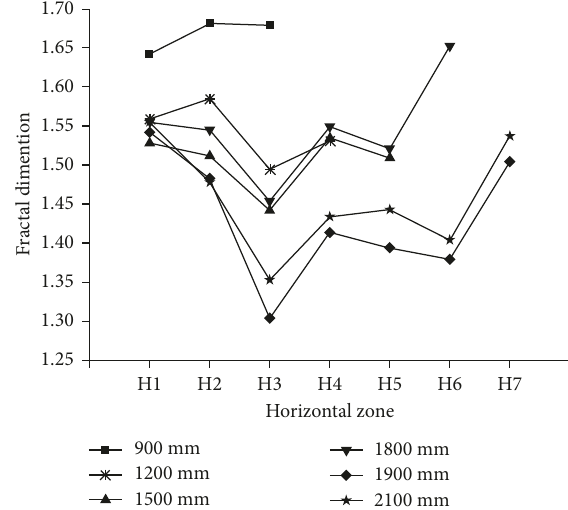
Figure 10: Evolution of the fractal dimension of crack network in different horizontal